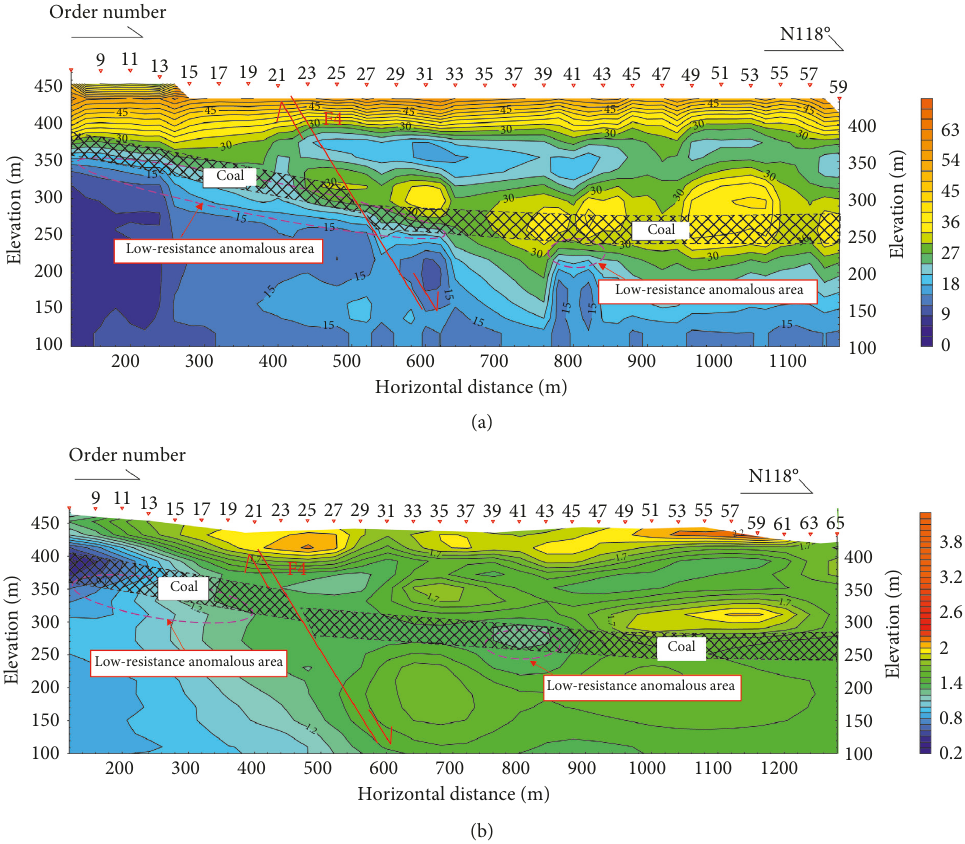
Figure 11: Resistivity sections obtained by different methods. (a) Inversion of the resistivity profile from line 5 of the TEM method. (b) Inversion of the resistivity profile from line 5 of the CSAMT